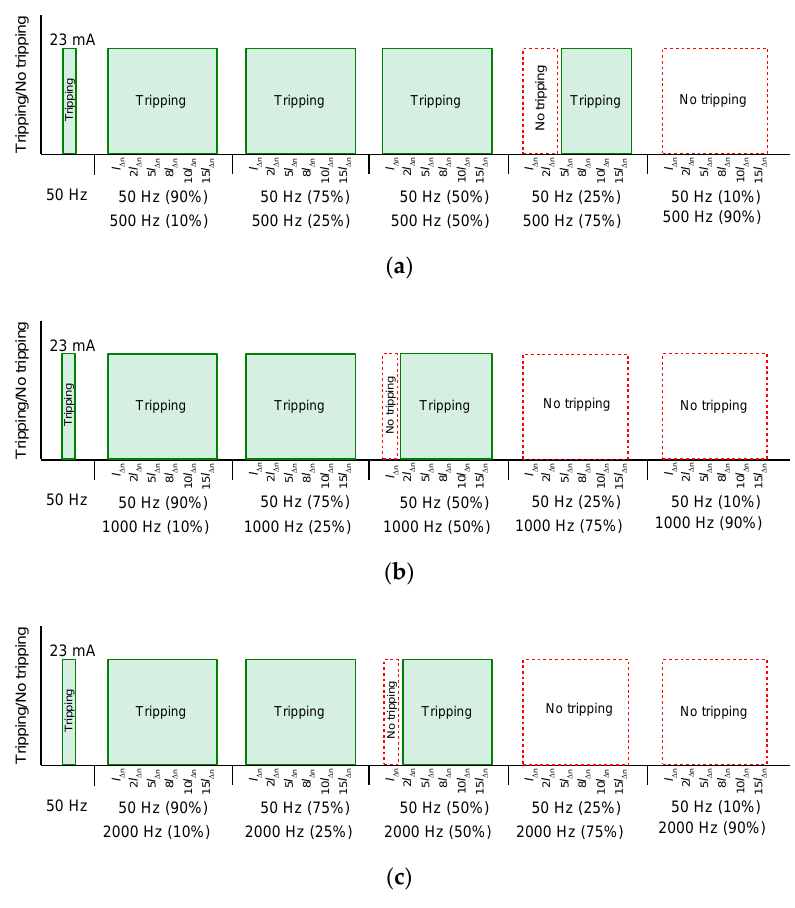
Figure 10. Tripping of the 30 mA A-type RCD (no. RCD_1A—symbol defined in Table 2) for waveform composed of the fundamental frequency (50 Hz) and high-frequency component: ( a ) 500 Hz; ( b ) 1000 Hz; ( c ) 2000 Hz. Values in brackets indicate the content of the particular component; 23 mA—real tripping current for a pure sinusoidal signal of 50 Hz.